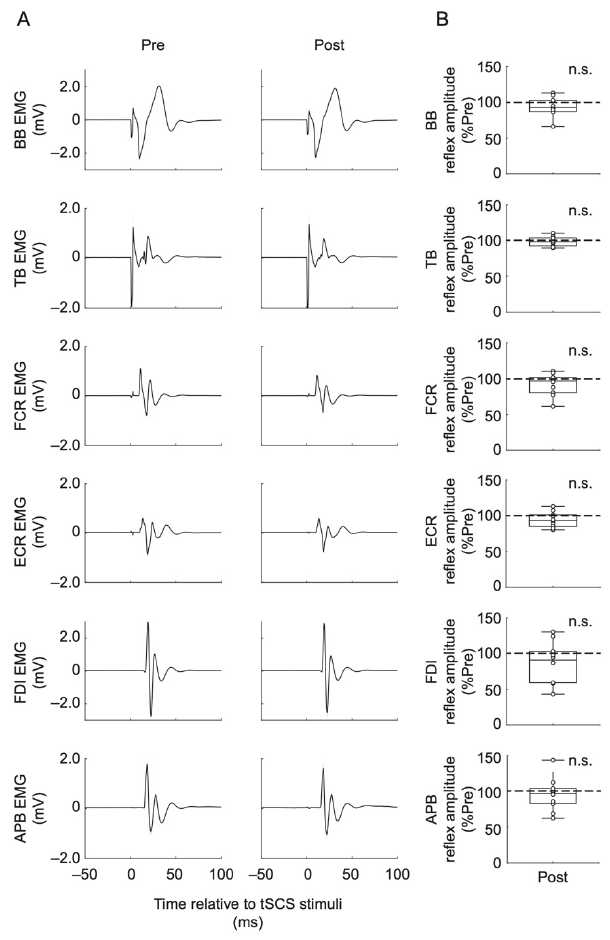
Figure 4. ( A ) Averaged spinal reflex responses for one representative participant at before (Pre) and after (Post) assessment points. Shadows represent standard deviation. ( B ) Box plots show posterior root muscle (PRM) reflex group data in the Post assessment point. PRM reflex amplitudes were normalized with respect to the PRM reflex amplitude during the Pre assessment (% of Pre) for each participant. Data are shown for the biceps brachii (BB), triceps brachii (TB), flexor carpi radi- alis (FCR), extensor carpi radialis (ECR), first dorsal interosseous (FDI), and abductor pollicis brevis (APB) muscles. The horizontal lines in the box plots indicate median values. The ends of the boxes represent the 25th and 75th percentiles. The whiskers on the box plots illustrate the minimum and maximum values. Legend: n.s., non-significant. 4. Discussion In the present study, we investigated the effects of relatively short-duration (10 min) and low-intensity (sub-motor-threshold) continuous cervical tSCS applied at rest on the upper-limb muscle MEPs elicited by TMS as well as PRM reflexes elicited by single-pulse cervical tSCS. Our results showed that the intervention did not significantly affect corti- cospinal (Figure 2) and spinal reflex excitabilities (Figure 4), suggesting that the utilized intervention did not effectively modulate the excitability of spinal monosynaptic con-